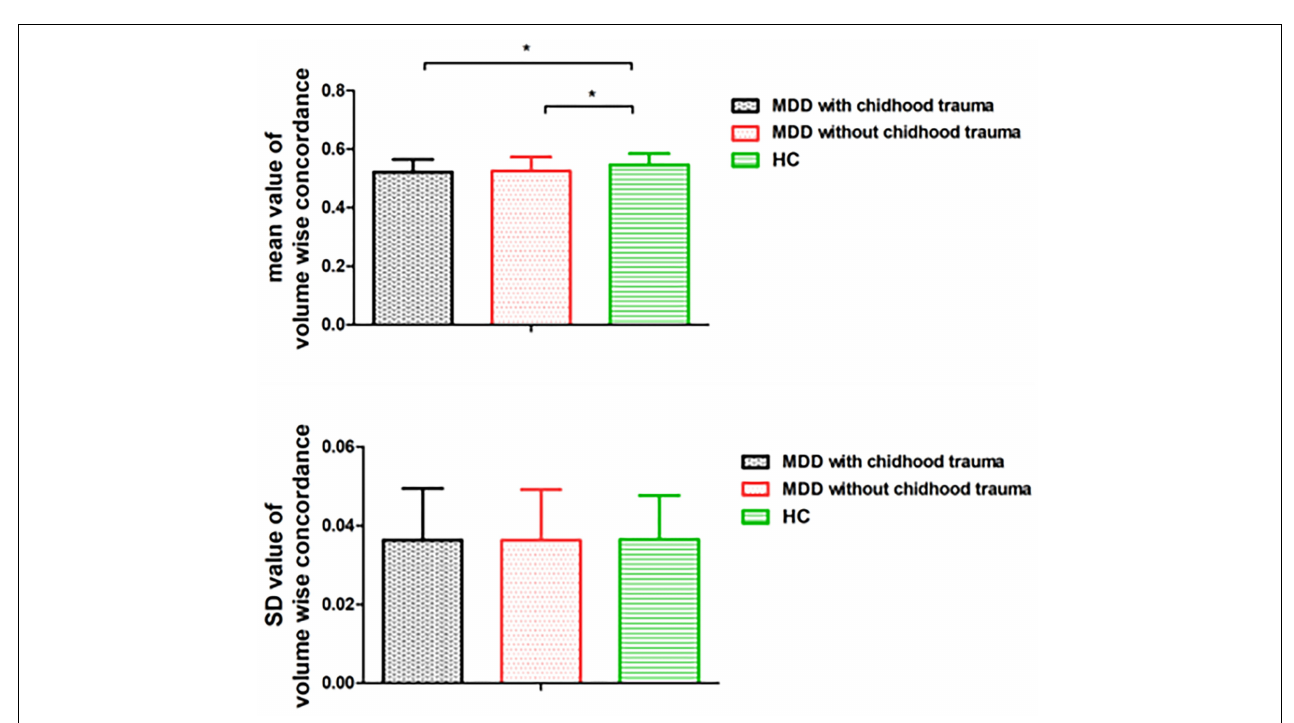
FIGURE 2 | Comparison of volume wise concordance among the MDD with childhood trauma, MDD without childhood trauma, and HC groups. MDD, major depressive disorder; HC, healthy control. * p < 0.05.